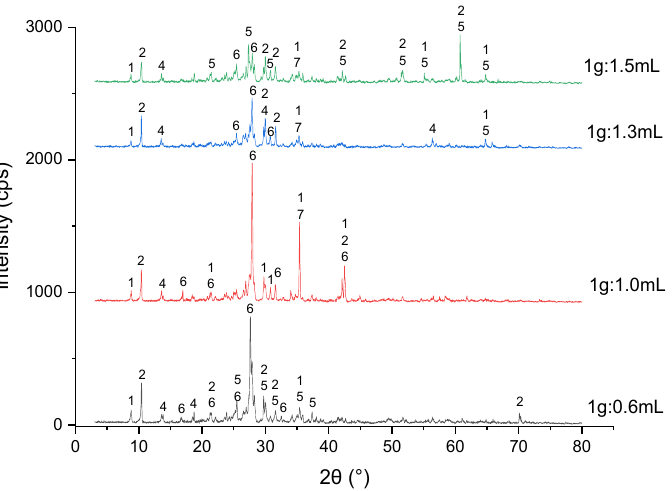
Figure 11. X-ray diffractogram of the samples and the main phases detected, varying the acid dosage. Experimental conditions for baking: 1 g of ore; T = 400 ◦ C; 2 h. Peaks: 1—dickite; 2—ferrohornblende; 3—fayalite; 4—hedenbergite; 5-albite; 6—iron sulphate; 7—hematite.